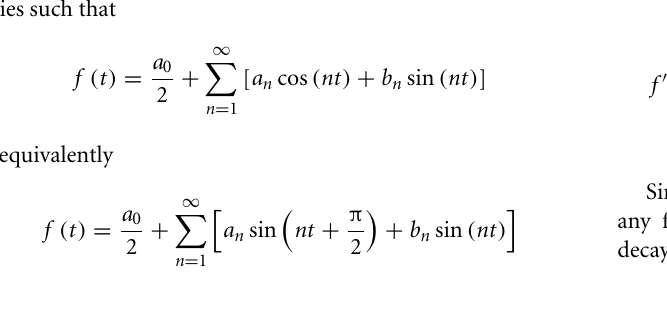
FIGURE 7 | (A) Comparison of p53 levels in the deterministic model in black to a curve fitted to it from the function f ( t ) = a 0 + a 1 sin ( ω t + ϕ 1 ) + a 2 sin ( 2 ω t + ϕ 2 ) in red. (B) Comparison of p53 levels in the stochastic model in black to a curve fitted to it from the function f ( t ) = a 0 + e − α 2 t 2 a 1 sin ( ω t + ϕ 1 ) + e − 4 α 2 t 2 a 2 sin ( 2 ω t + ϕ 2 ) in